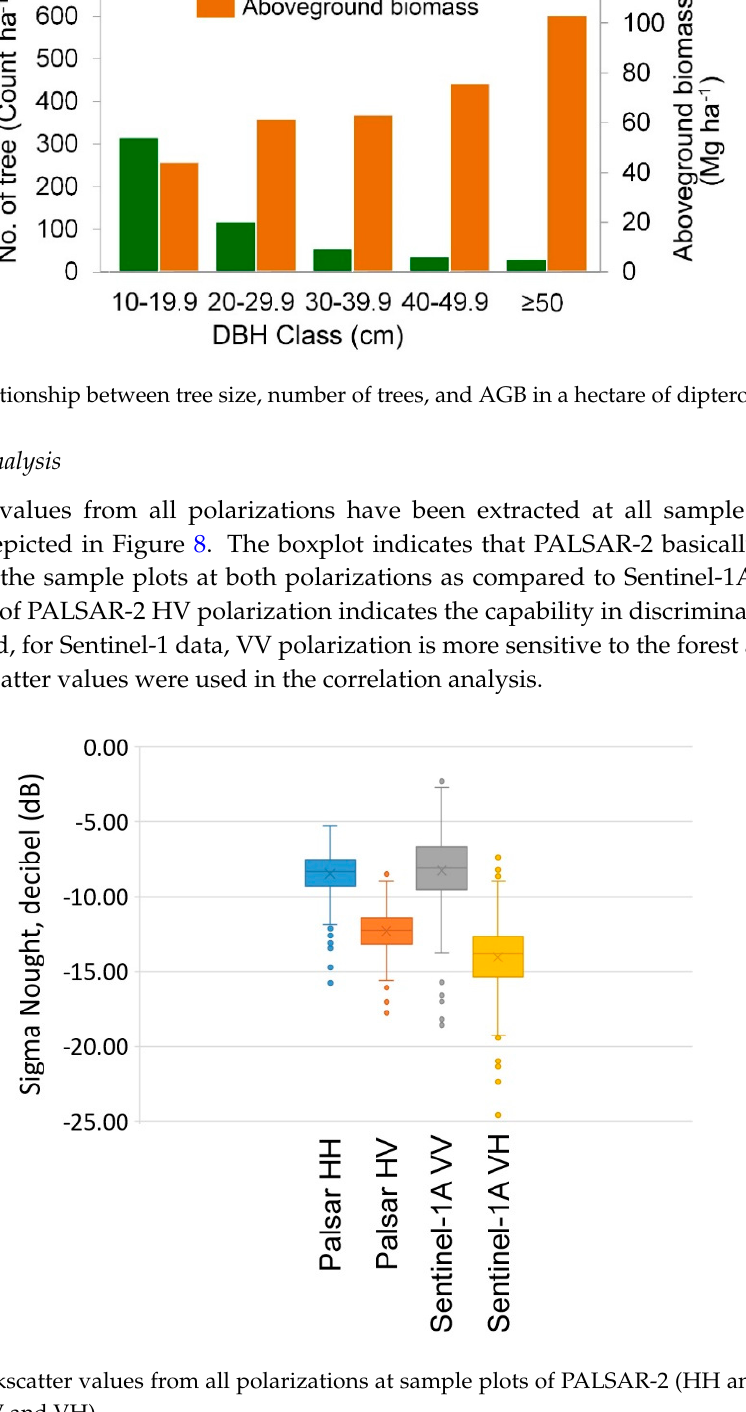
Figure 8. Backscatter values from all polarizations at sample plots of PALSAR-2 (HH and HV) and Sentinel-1 (VV and VH).